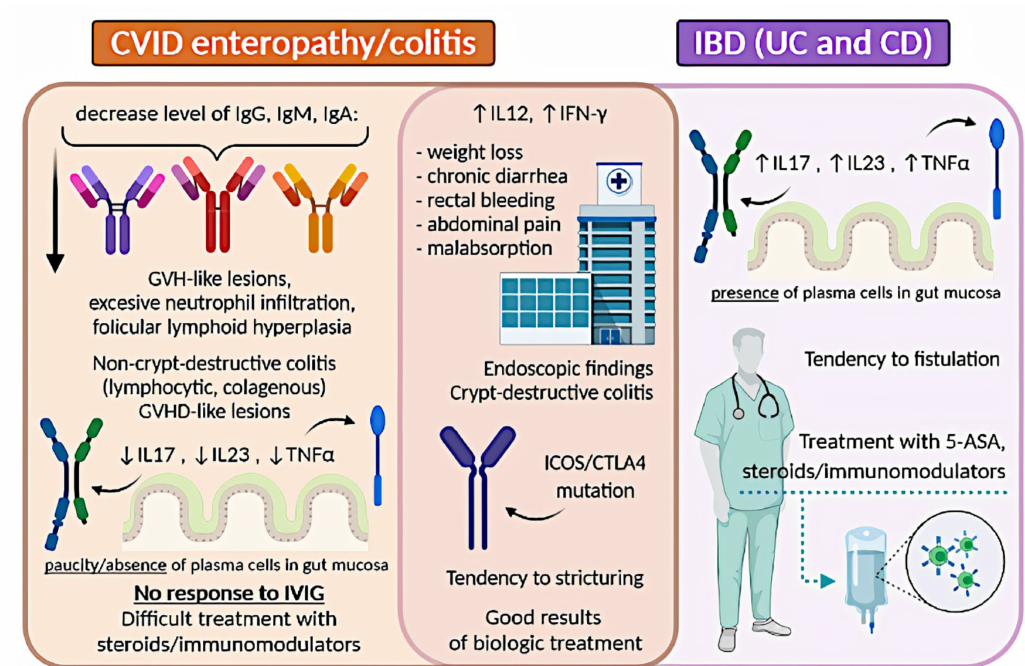
Figure 4. Comparrison of IBD and CVID enteropathy / colitis. CVID, common variable immunodeficiency; IBD, inflammatory bowel disease; UC, ulcerative colitis; CD, Crohn’s disease; GVH, graft-versus-host; IL, interleukin; TNF- α , tumor necrosis factor-alpha; IVIG, intravenous immunoglobulin; INF- γ , interferon-gamma; 5-ASA, 5-aminosalicylic